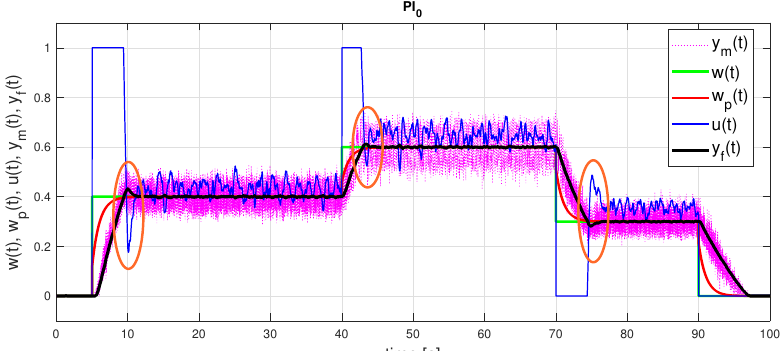
Figure 8. PI 0 control: setpoint responses corresponding to IPDT approximations of an initial part of a normed step response y n ( t ) (42) with the parameters (44) and with emphasis on areas including overshooting output requiring compensation by an additional input